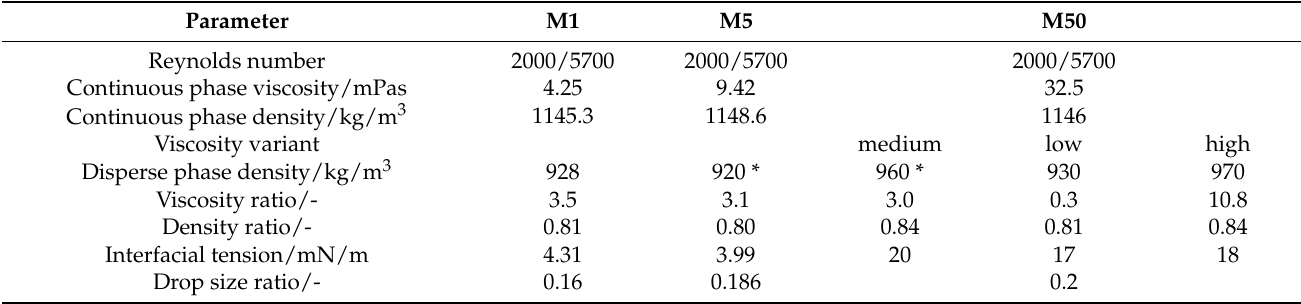
Interfacial tension/mN/m Drop size